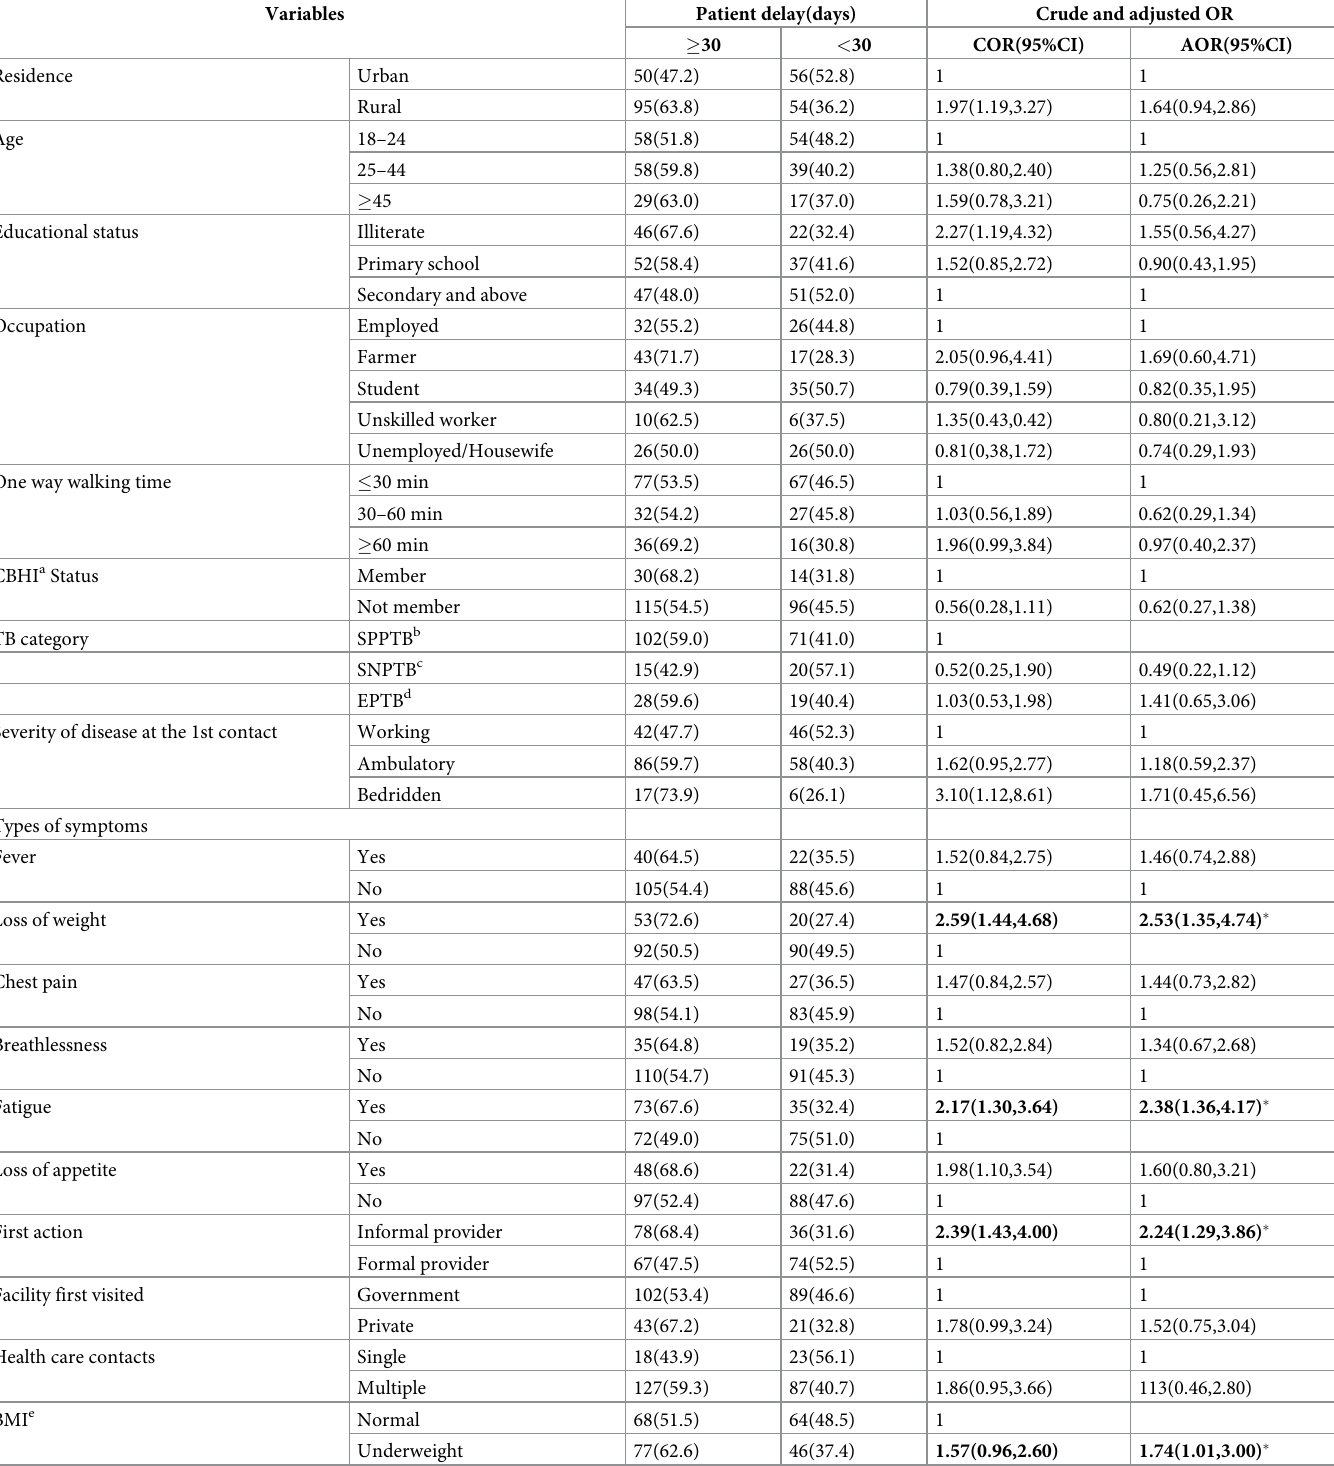
Table 5. Factors associated with patient delay among TB patients in Gamo zone public health facilities, Southern Ethiopia, bivariate and multivariate analysis, 2019.